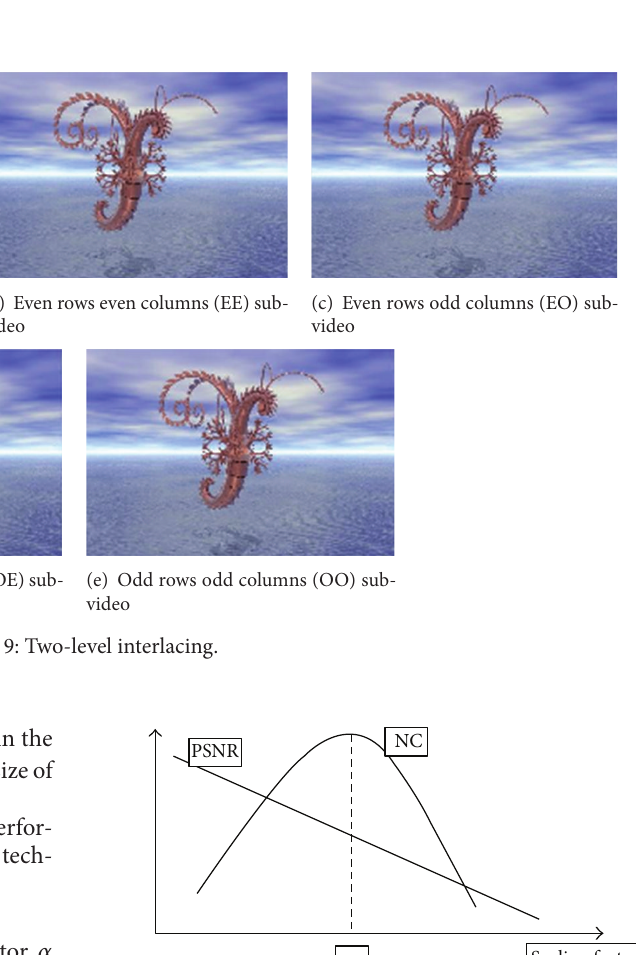
Figure 10: Scaling factor versus PSNR and